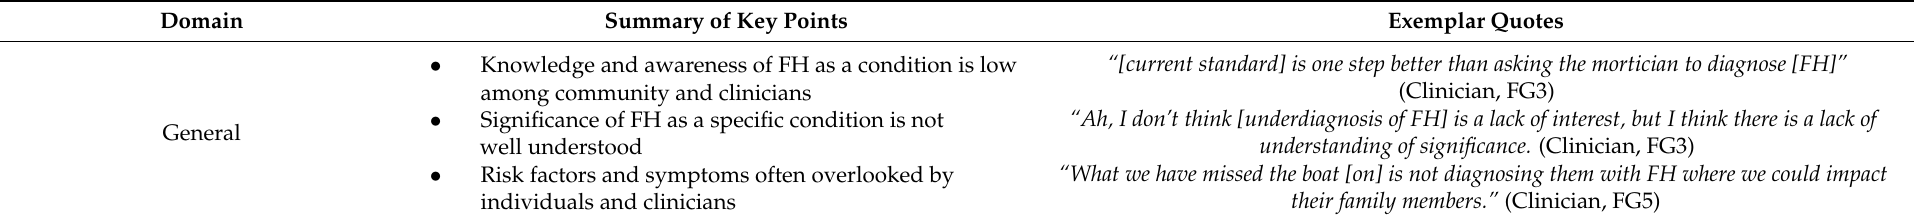
Table 3. Key points with exemplar quotes related to general acceptability and specific acceptability related to automated screening approaches and family communication